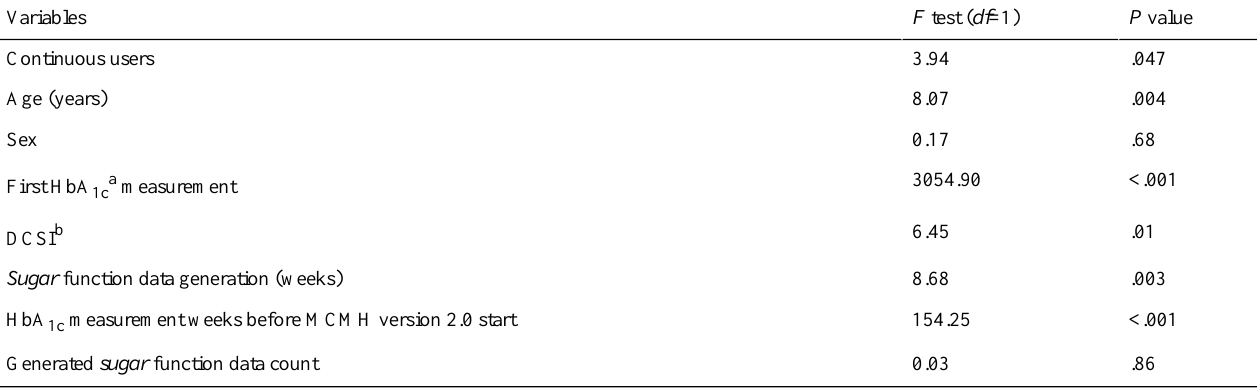
Table 2. Results of adjusting confounders with the analysis of covariance in decline